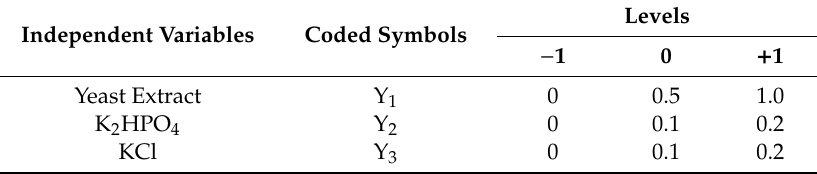
Table 6. Variables and level for Box–Behnken design for the optimisation of nutrient supplements. Independent